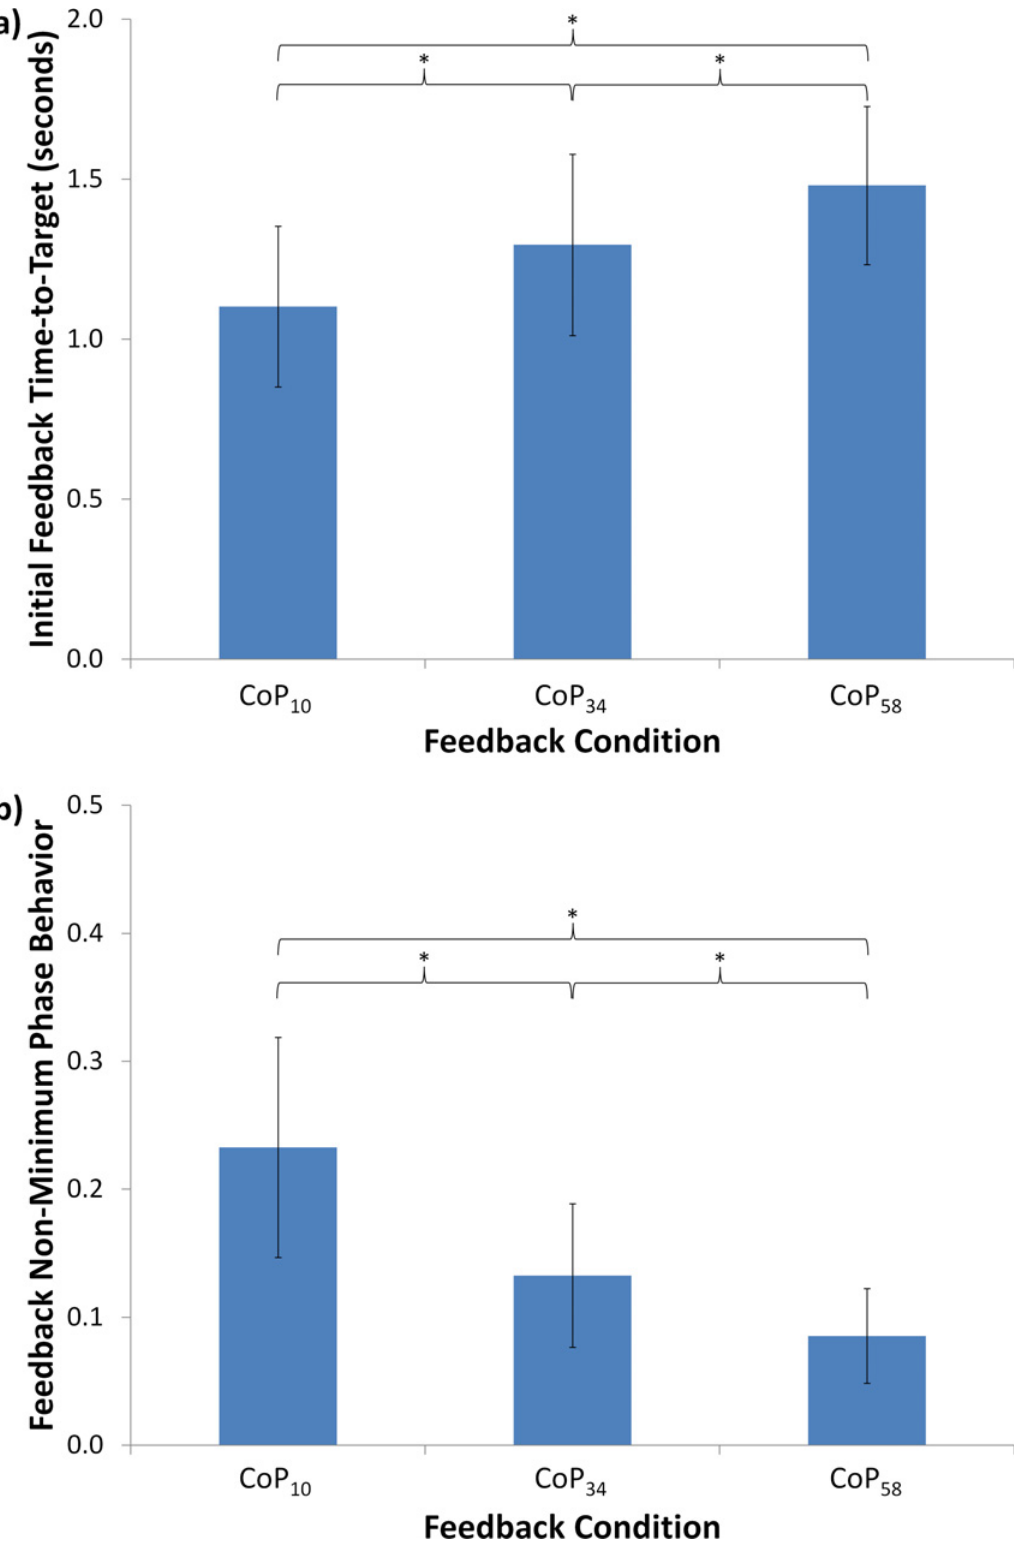
Fig 4. VFB Performance Results. Average values for VFB indicator performance based on (a) initial feedback time-to-target and (b) feedback non-minimum phase behavior across the three filtered feedback conditions. Bars indicate one standard deviation. * : p <